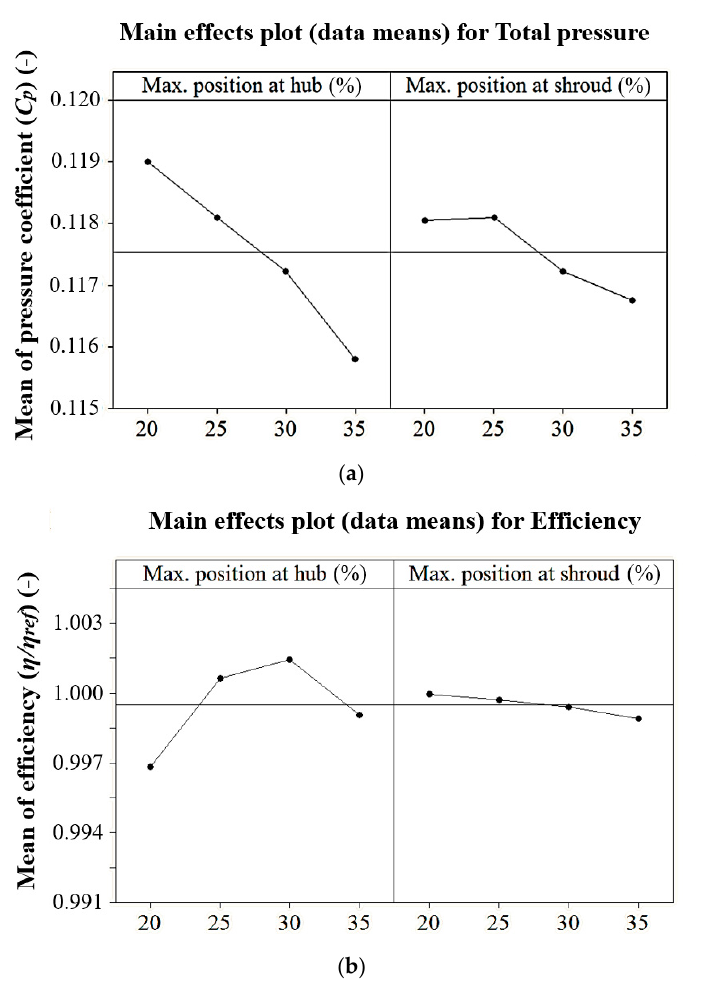
Figure 11. Main effect plots for the maximum thickness position of each span: ( a ) total pressure; ( b ) efficiency.